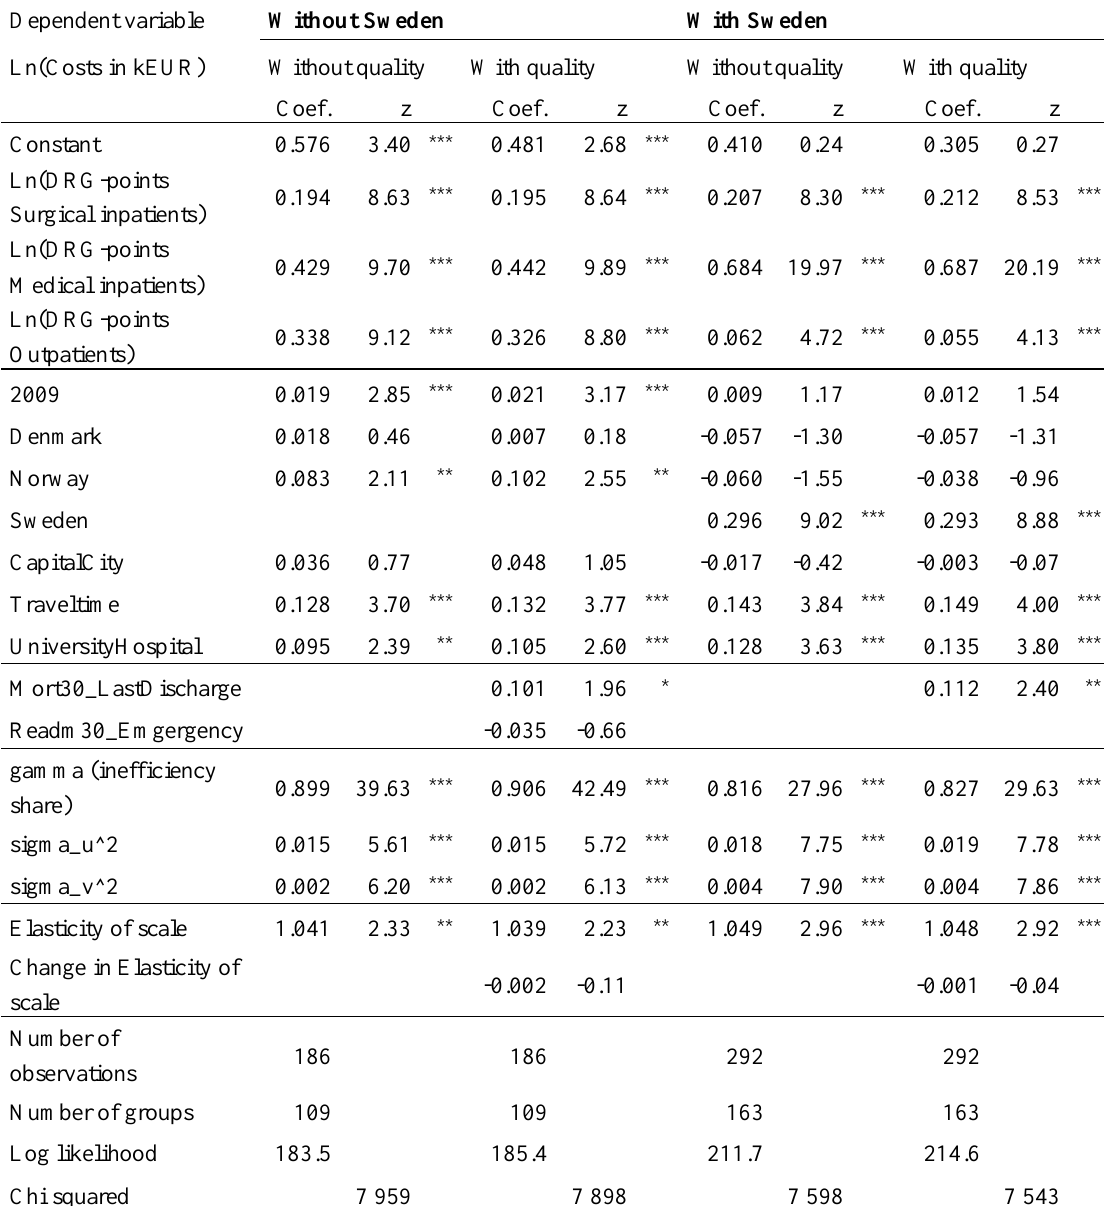
Table 2: Results from Maximum likelihood panel estimation of stochastic frontier cost functions with time invariant